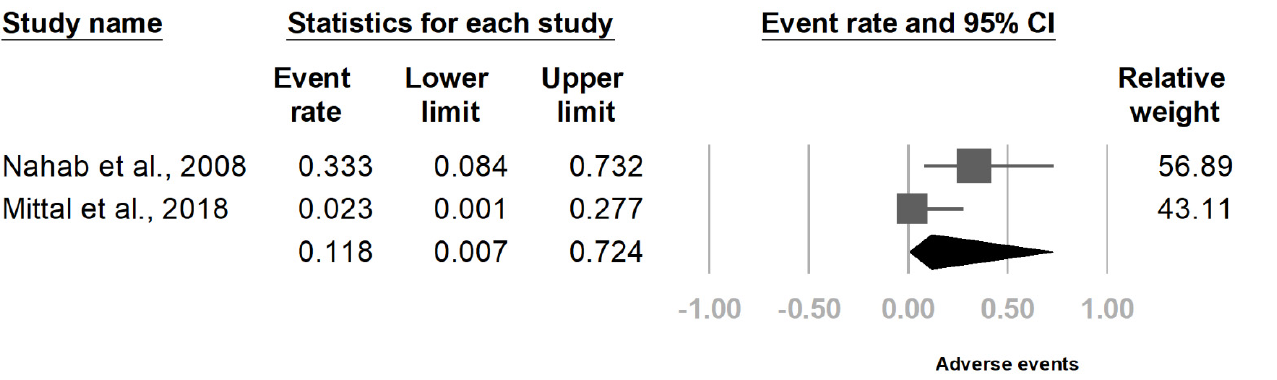
Figure 4. Forrest plot of adverse event rate in the intervention groups after botulinum toxin administration. Squares indicate the rate of individual studies, lines indicate 95% CI, and the diamond indicates the summarized result.